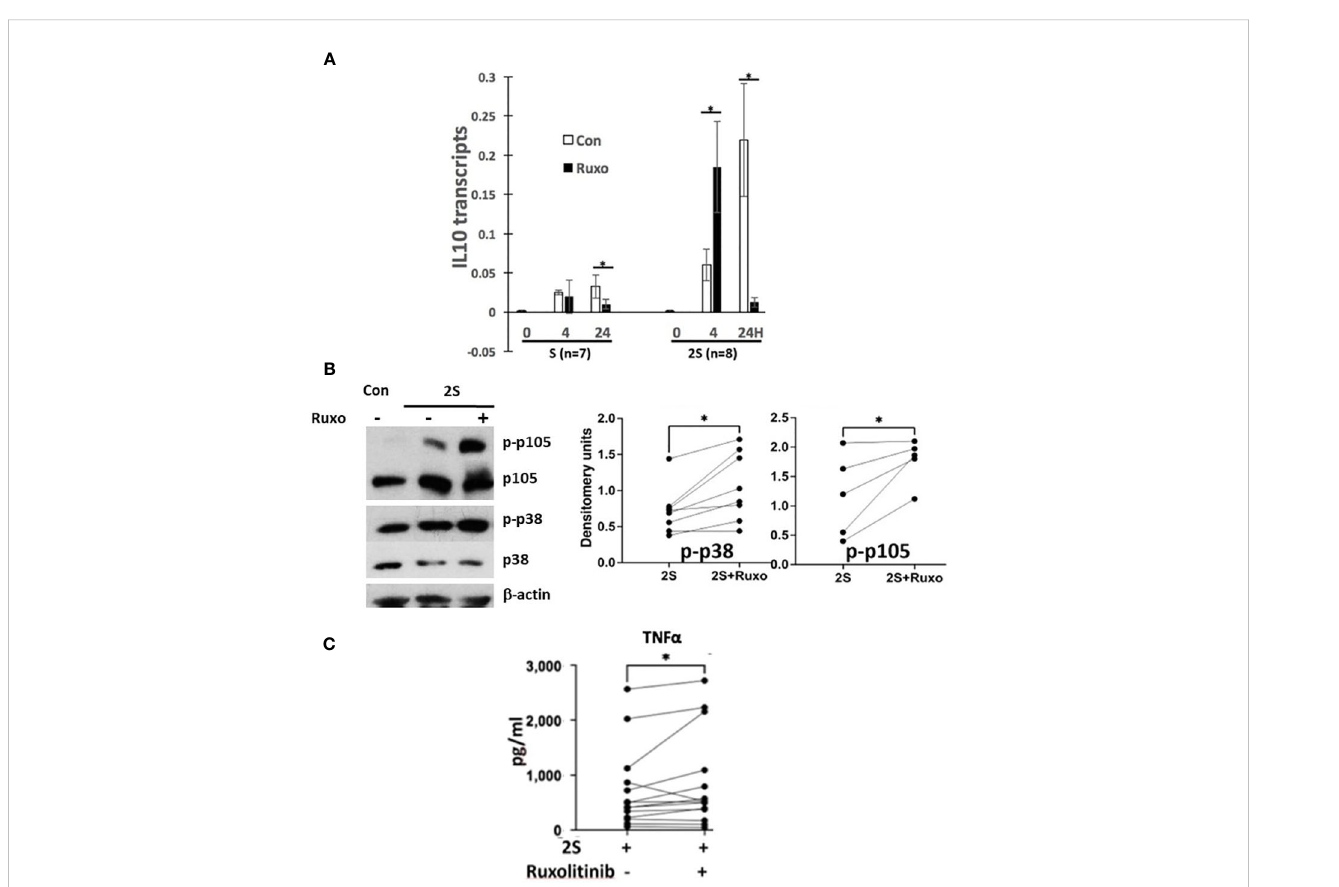
FIGURE 3 Effect of ruxolitinib on IL10 transcription, p38 and NF k B-signaling and TNF a production by activated CLL cells. Puri fi ed CLL cells were cultured in AIM-V alone (Con), with resiquimod (S28) (1 m g/ml), or with IL-2 (500 U/ml) and resiquimod (2S) in the presence or absence of ruxolitinib (Ruxo) (500 nM). (A) IL10 transcripts were measured after 4 and 24 h by quantitative RT-PCR. (B) Phospho-p38 and -p105 were measured by immunoblotting and densitometry and normalized to b -actin. Examples of immunoblots are shown. (C) TNF a in culture supernatants was measured after 48 h. Lines and dots in the graphs represent results for individual patient samples. *, p<.05. Statistical analysis was done with students paired t tests and 2-way